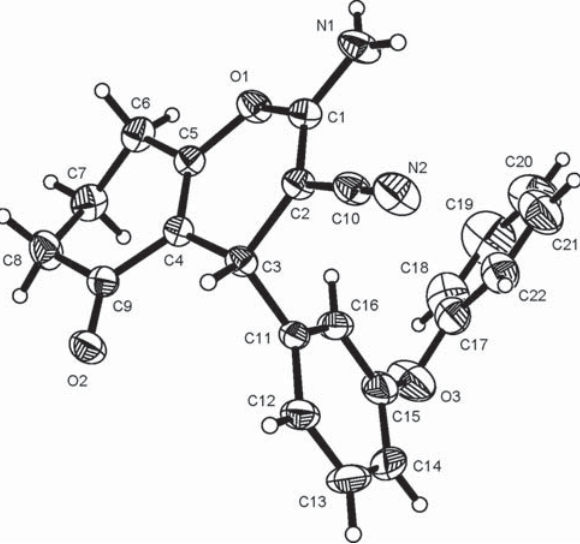
Table 1: Data collection and handling.